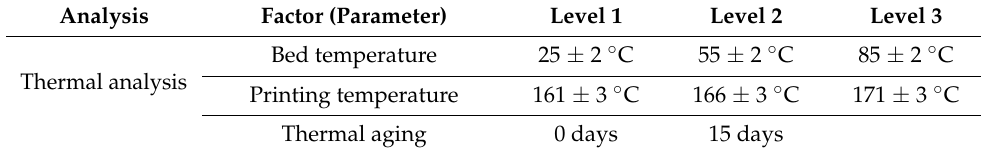
Table 2. Design of experiments for the analysis of thermal treatment (aging).